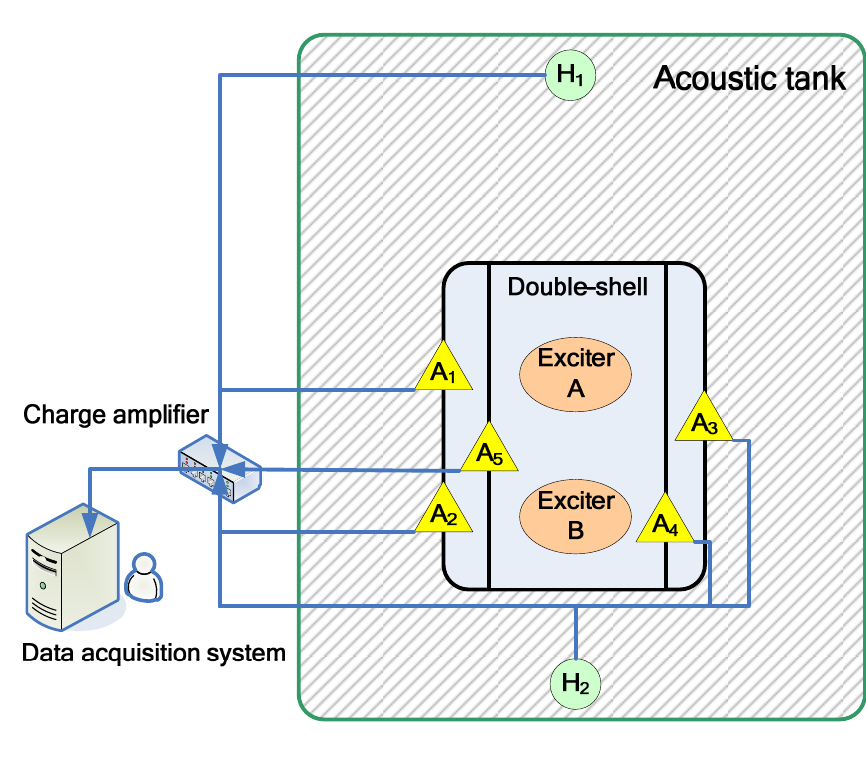
Figure 7. Sketch of the